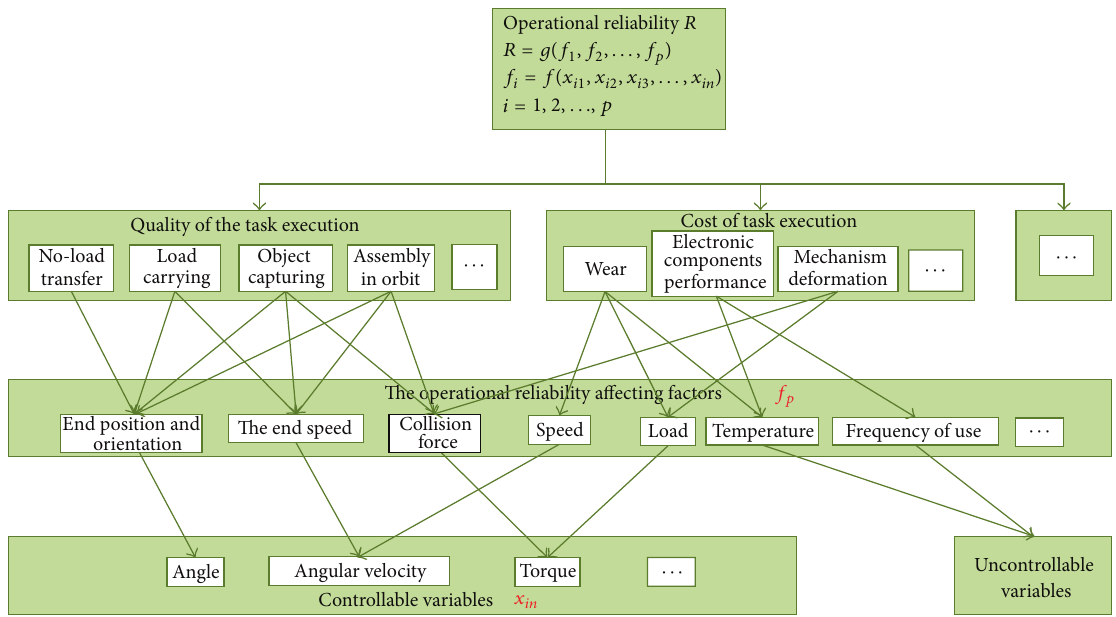
Figure 1: Multiconstrained multivariable integrated optimization